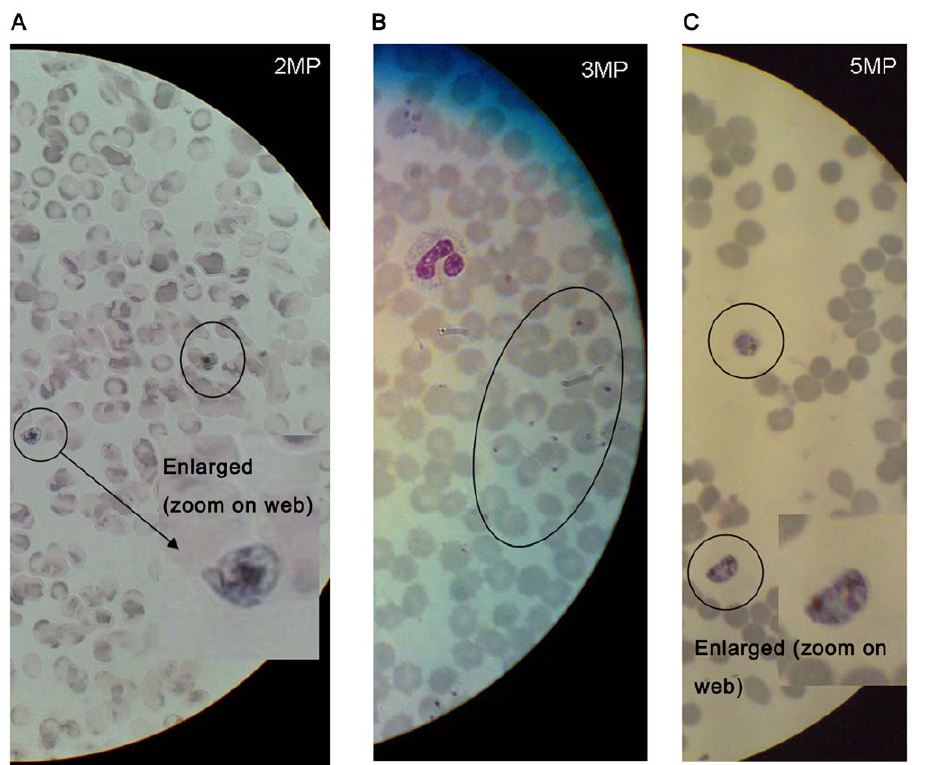
Figure 2. Pictures from malaria parasites stained with a regular Giemsa stain and visualized by light microscopy (field 100 6 oil immersion) taken with mobile phone cameras with different resolutions. Panel 2A shows a 2 MP image and panel 2C a 5MP image of malaria parasites. Inside the black circles different stages of the parasites (schizonts and gametocytes) are visible. The middle panel 2B shows a 3MP image of a white blood cell and inside the black circle, malaria trophozoites.